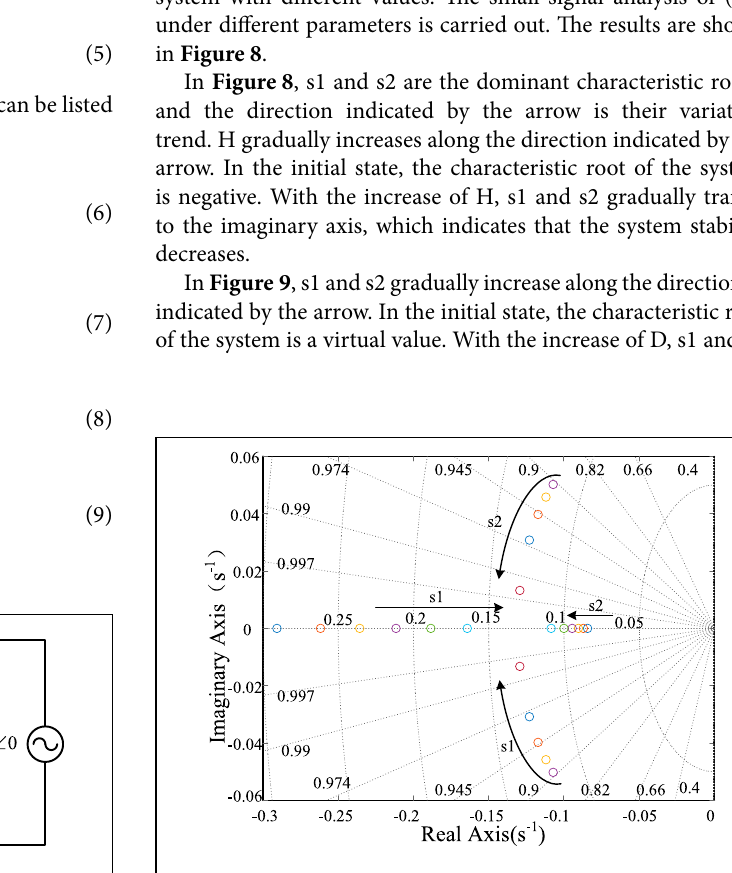
FIGURE 7 | Equivalent circuit of actively supported VSC after conversion. FIGURE 8 | Trajectories of characteristic roots for H from 40 to 70 at D =